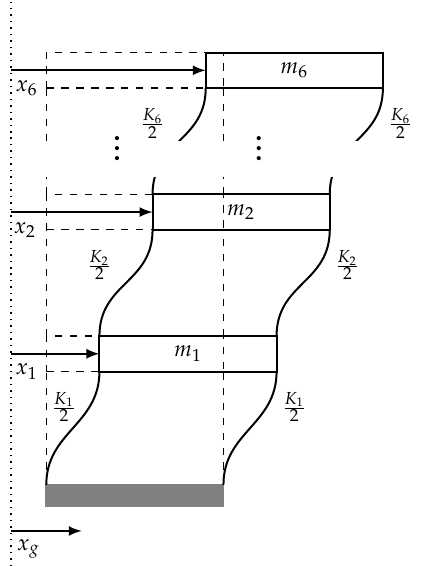
Figure 15. Six-storey shear frame with m i = 80 Mgr subject to uniaxial earthquake motion.